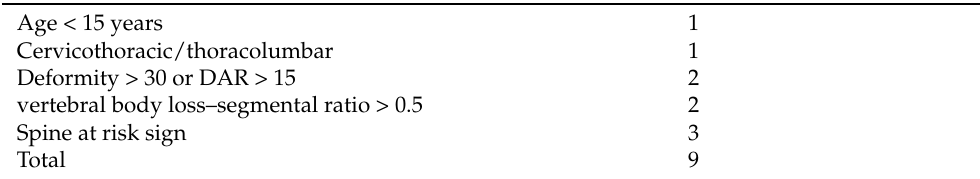
Table 1. A validated score to evaluate spinal instability to assess surgical candidacy in active spinal tuberculosis.